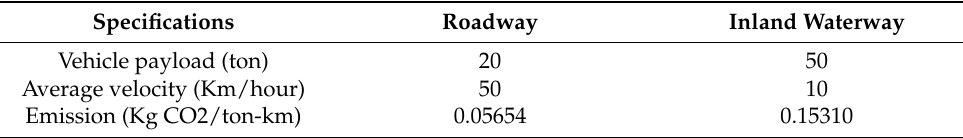
Table 6. Vehicle Table 6. Vehicle specifications.